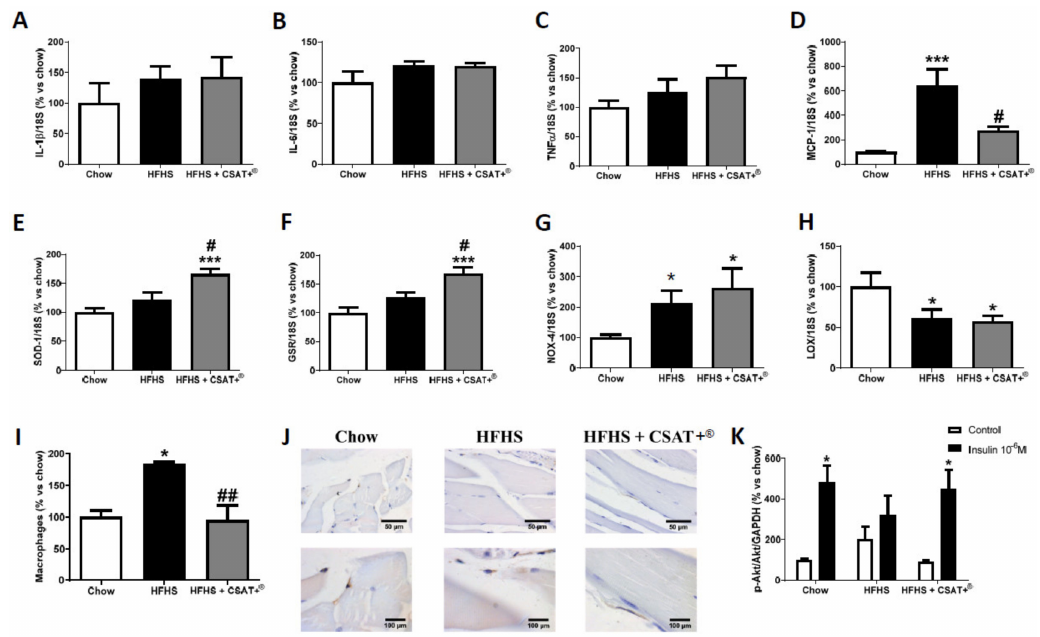
Figure 3. mRNA levels of interleukin-1 beta ( A ), interleukin-6 ( B ), tumor necrosis factor-alpha ( C ), monocyte chemoattractant protein ( D ), superoxide dismutase-1 ( E ), glutathione reductase ( F ), NADPH oxidase-4 ( G ), and lipoxygenase ( H ) in gastrocnemius muscle of mice fed a standard diet (Chow), a high fat diet / sucrose diet (HFHS), or high fat diet / sucrose diet supplemented with the carob pod extract (HFHS + CSAT + ® ). Macrophages infiltration was measured by immunohistochemistry ( I , J ) and pAKT / AKT ratio ( K ) was measured in this gastrocnemius explants after 15 min of incubation with or without 10 − 6 M insulin. * p < 0.05; *** p < 0.001 vs. chow. # p < 0.05; ## p < 0.01 vs. HFHS. Values are represented as mean ± S.E.M; n = 5–8 samples / experimental